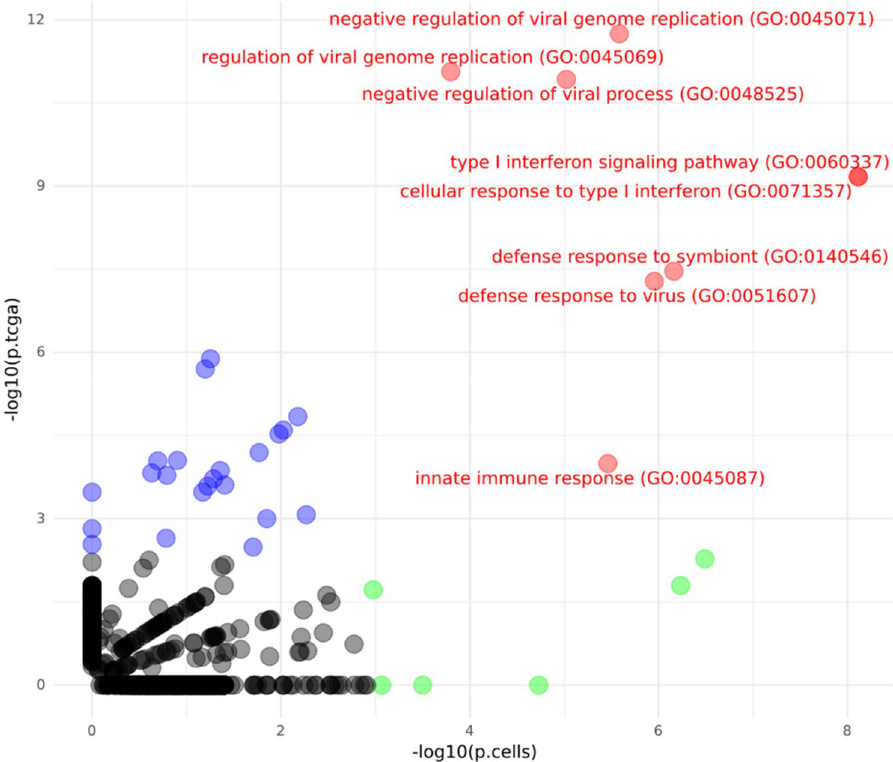
Figure 4. Enriched GO Pathway Terms in Cell Lines vs. TCGA data. -log 10 p-values from hypergeometric test from enrichment analysis for differentially expressed genes in cell lines (x-axis) and TCGA (y-axis). Red color indicates gene sets where adjusted p < 0.05 in both cell lines and TCGA enrichment analysis, blue only TCGA, and green only cell